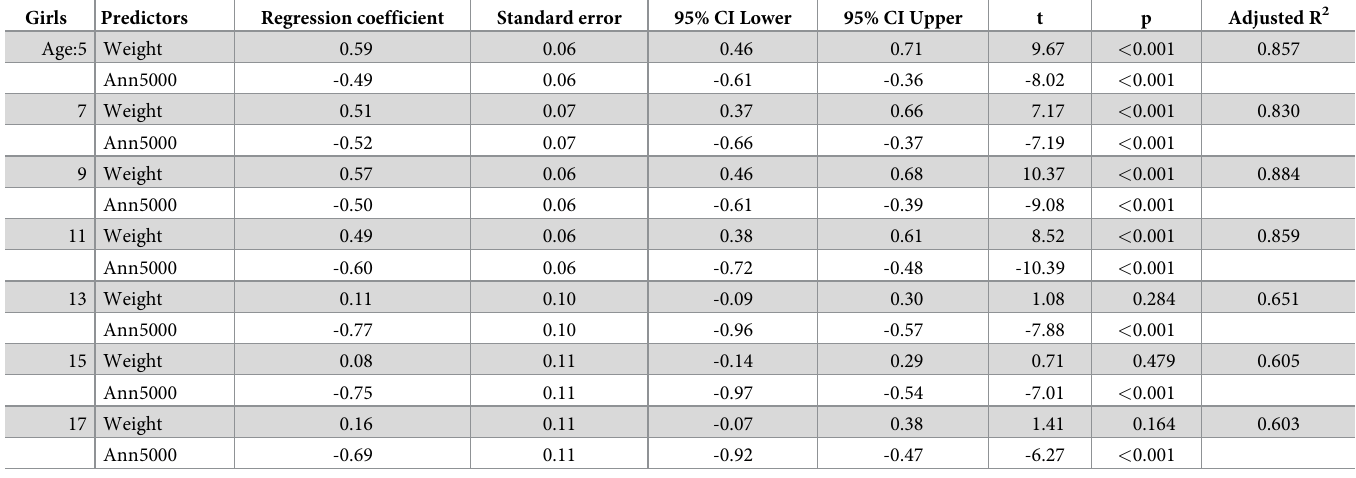
proximal promoter region of Dio3 (Deiodinase Type III, which catabolizes thyroid hormone T4 to the inactive enantiomer rT3) and increased hypothalamic Dio3 expression. De-methyla- tion during the short winter day length was reversed, and methylation was promoted in antici- pation of spring, as showed by re-methylation of the Dio3 promoter and reduction in Dio3 mRNA, resulting in spontaneous reproductive development. Short winter day length and win- ter like melatonin inhibited DNA methyltransferase expression and reduced Dio3 promoter DNA methylation [13]. This means that the greater the de-methylation induced by short win- ter day length, the more pronounced the re-methylation and thyroid hormone activation in the spring. This mechanism lends support to the idea that quantitative information imparted by the short day length in winter is retained until summer [12]. Table 5. Regression coefficients (standard errors) of predictors of height